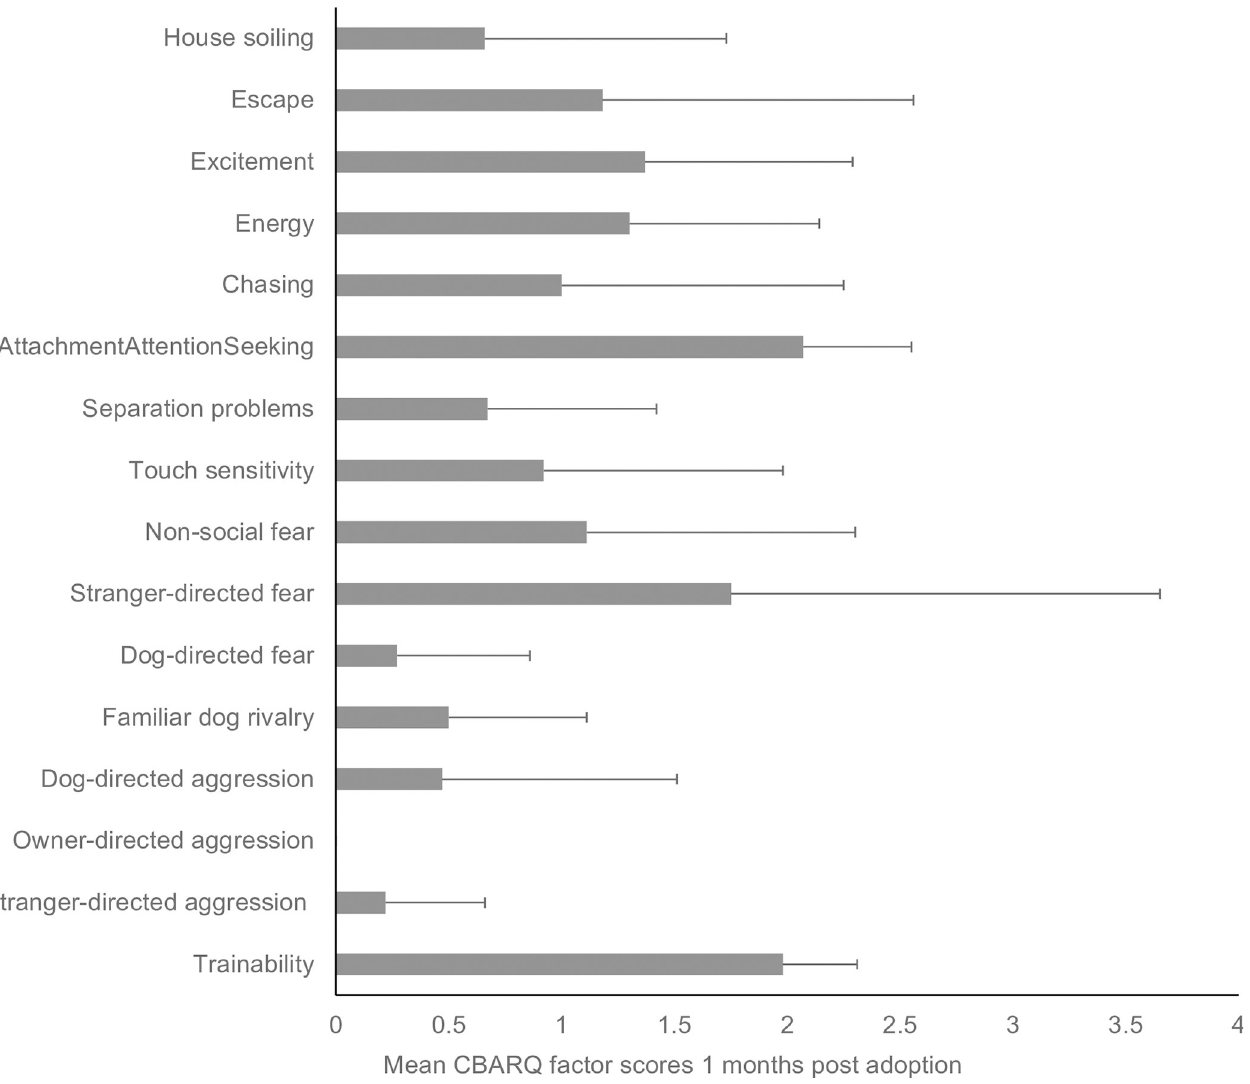
Fig 6. Mean CBARQ scores for selected subscales. Mean statistics of the CBARQ behavioral sub-scale scores, and of relevant CBARQ items included in miscellaneous (i.e., house soiling, escape) obtained from the owners of the 32 rehomed dogs 1 month after adoption. CBARQ scale ranges from 0–4 where 0 is a behavior not observed and 4 is a behavior often observed in the